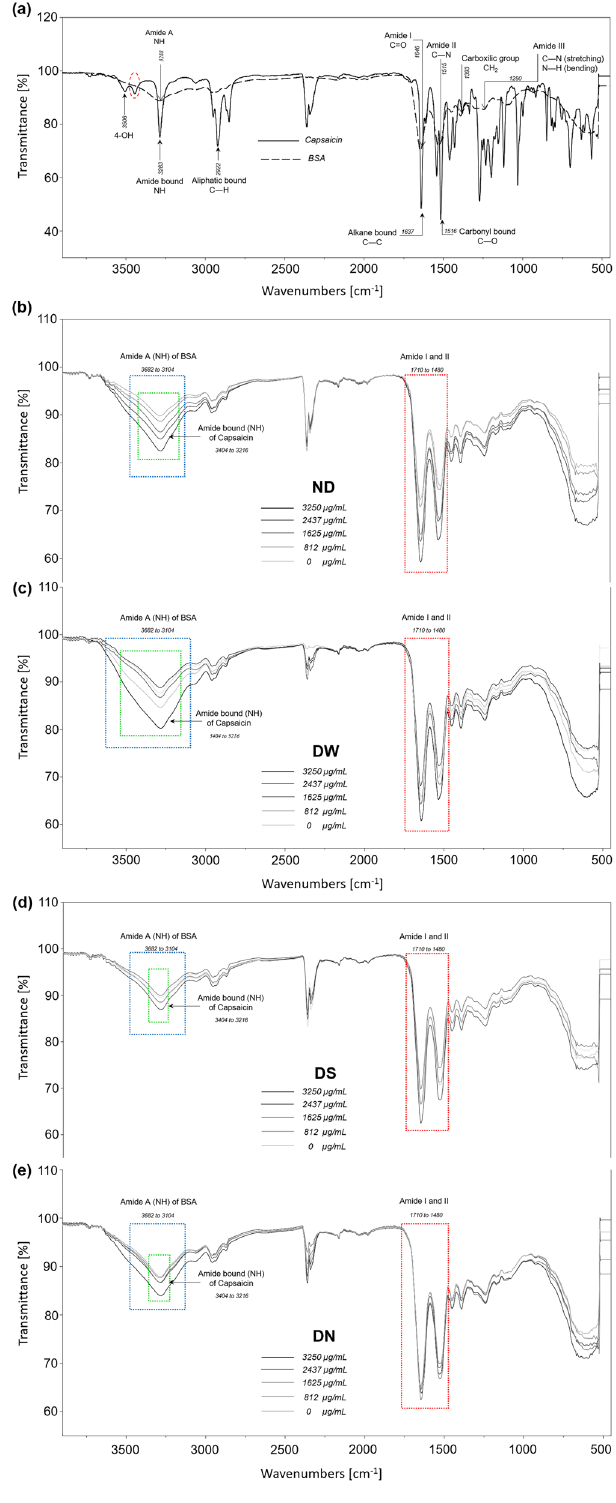
Figure 3. Molecular changes of the BSA-capsaicin nanoparticles after drying treatments with several excipients and the effect of the increment of capsaicin in the nanostructuration. ( a ) FTIR spectrum of native BSA (dotted line) and pure capsaicin (solid line); the scanning spectral range was between 4500 and 400 cm −1 . ( b ) FTIR spectral characterization of not dried treatment (ND) of BSA-capsaicin nanoparticles at 0, 812, 1625, 2437 and 3250 µg mL −1 , rectangles show the main change in amide A and bound amide of capsaicin. ( c ) NPs dried with water (DW), rectangles show changes in alkane and carbonyl bonds, functional groups associated with molecular water. ( d ) NPs dried with sucrose (DS), spectra did not show deformation. ( e ) NPs dried with NaCl (DN), spectra showed a low deformation in treatments from 0 to 2437 μg mL −1 of capsaicin concentration, at 3250 μg mL −1 an increase of transmitted signal of the capsaicin was